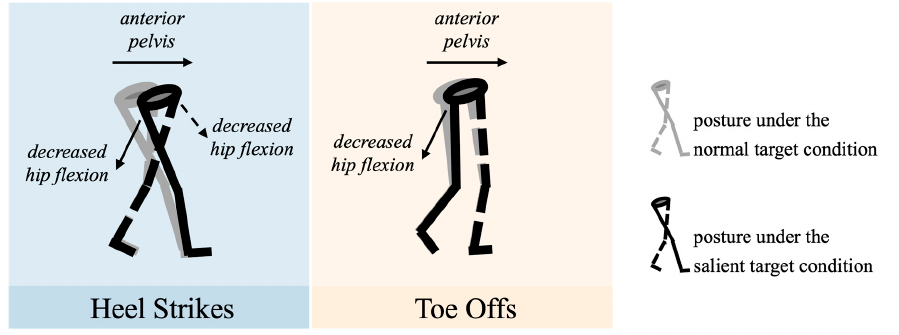
Figure 8. Illustration of participants’ lower-body posture at heel strikes ( left ) and toe offs ( right ) under the normal target condition (gray) and the salient target condition (black).